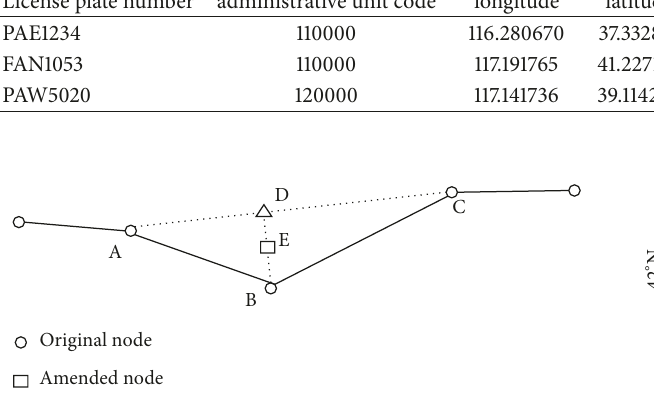
Figure 5: Schematic diagram of smoothing method (from Li et al.)[34].